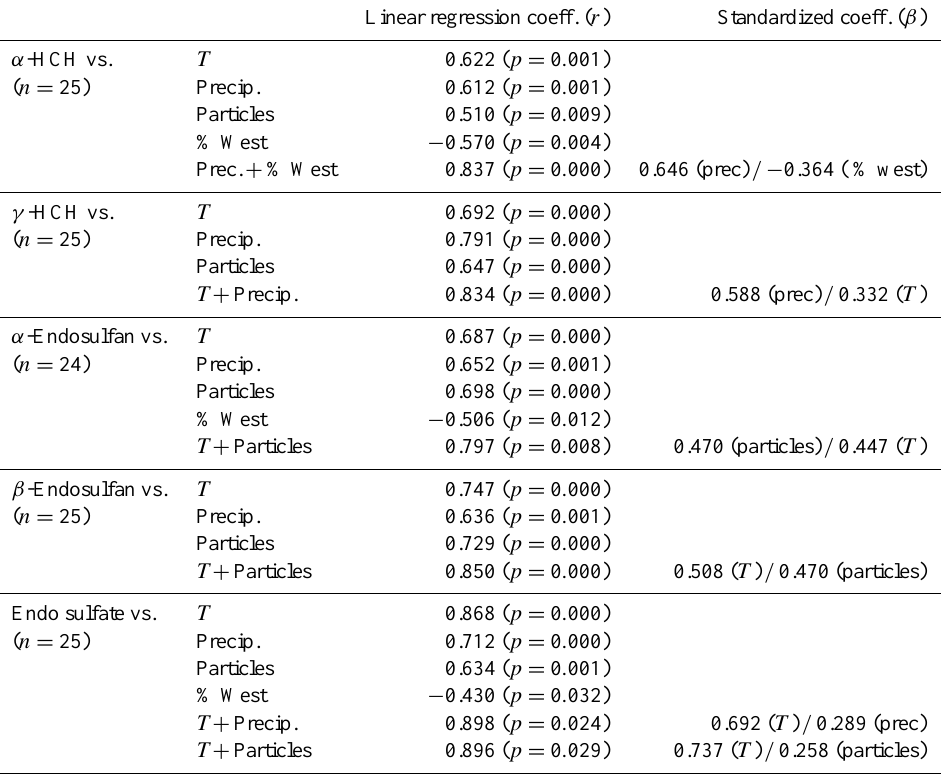
Table 5. Linear regression analysis between OC deposition fluxes (ngm − 2 mo − 1 , log-transformed values), monthly mean temperature ( T , ◦ in Skalnaté. Only compounds with statistically significant multilinear regression model are